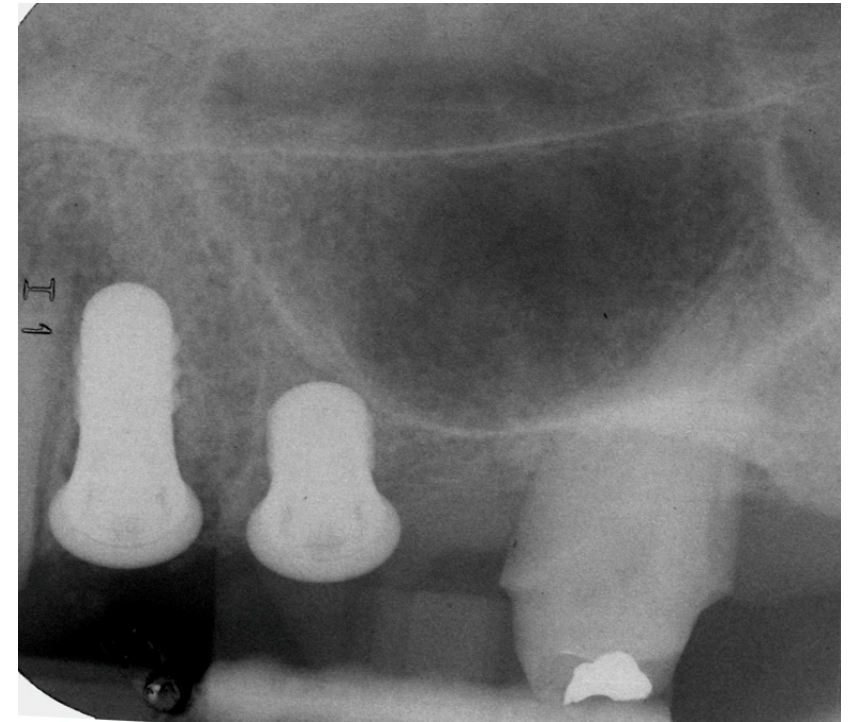
Figure 3. Radiograph of extra short and long implants at implant placement.